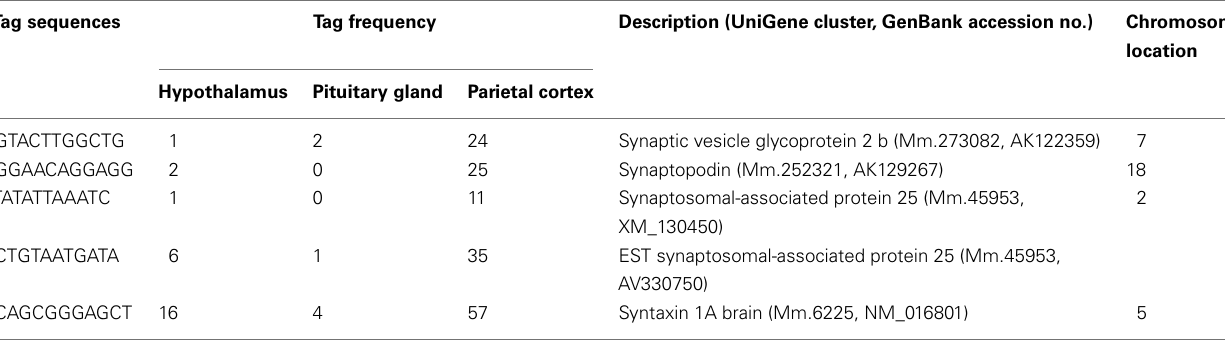
TableA3 | Components of synapse preferentially expressed in the